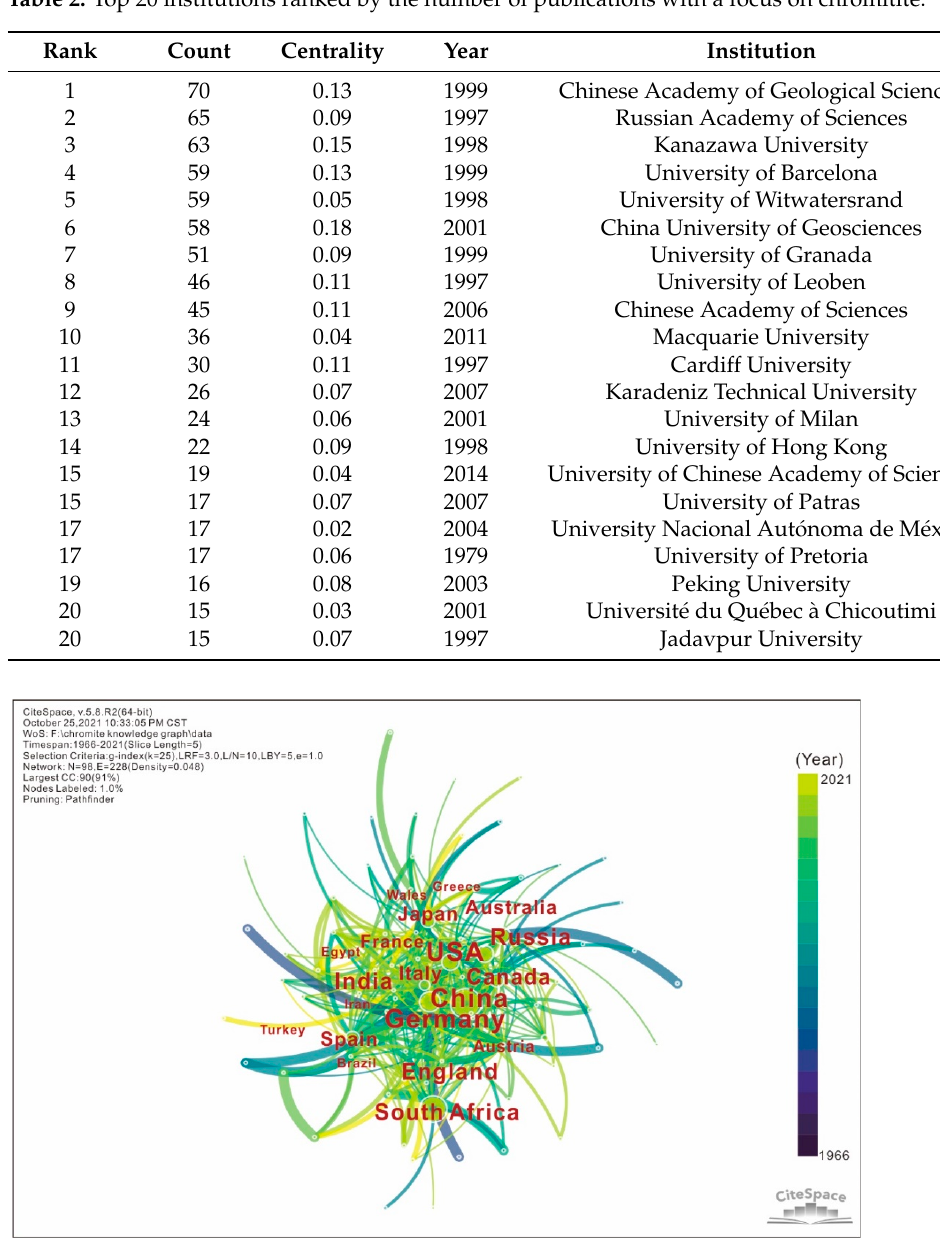
Table 2. Top 20 institutions ranked by the number of publications with a focus on chromitite.